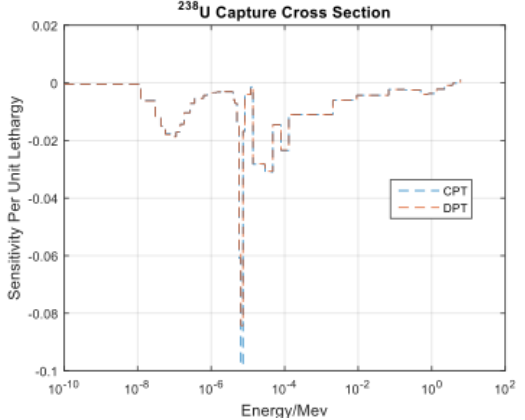
Figure 1. The SF96 benchmark model Figure 4. The sensitivity per unit lethargy of k to the 238 U capture cross sections